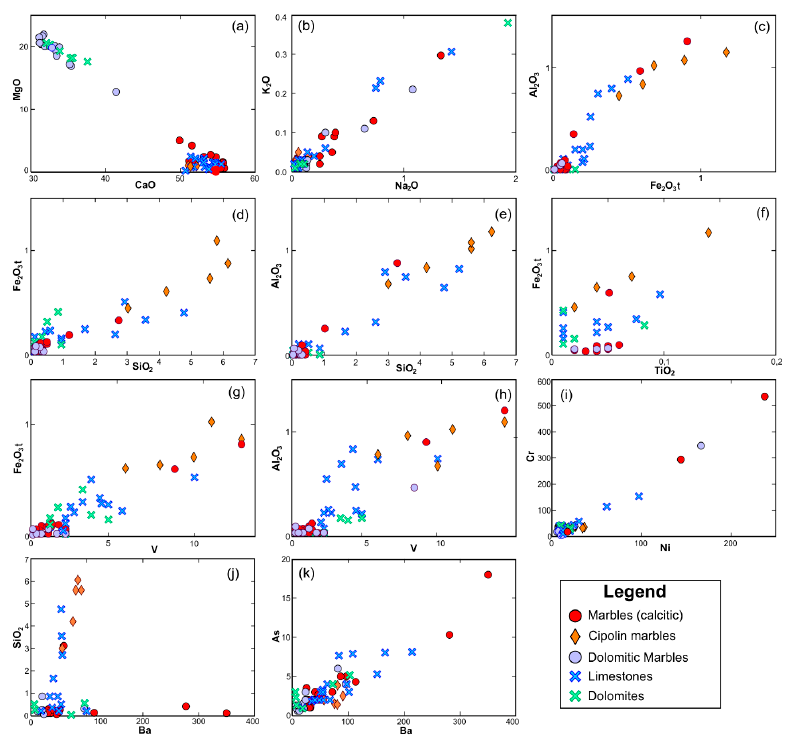
Figure 5. ( a – k ) Binary plots of selected major and trace elements, displaying their chemical behavior. Diagrams ( b , k ) are modified from Badouna et al., 2016 [14].